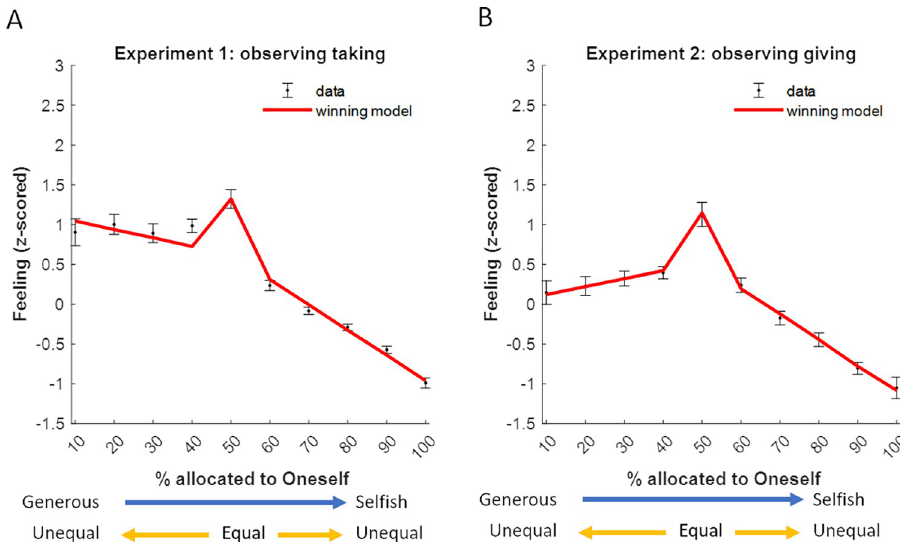
Fig 5. Modelling observers’ feelings as a function of observed selfishness and inequality. Plotted is the winning model (model 26) fit at the group-level for Experiment 1 ( A ; Feeling ¼ 1 : 7 (cid:0) 1 : 86 Selfishness (cid:0) 0 : 52 Inequality (cid:0) 0 : 44 Selfishness � Endowment þ 0 : 70 even split ) and Experiment 2 ( B ; Feeling ¼ 1 : 1 (cid:0) 0 : 88 Selfishness (cid:0) 1 : 1 Inequality (cid:0) 0 : 42 Selfishness � Endowment þ 0 : 63 even split ). Participants’ feelings ratings were z-scored before model-fitting to standardized responses. The predicted feelings from the model (red line) is overlaid on the mean observed feelings over all participants (black dots). Error bars represent SEM.